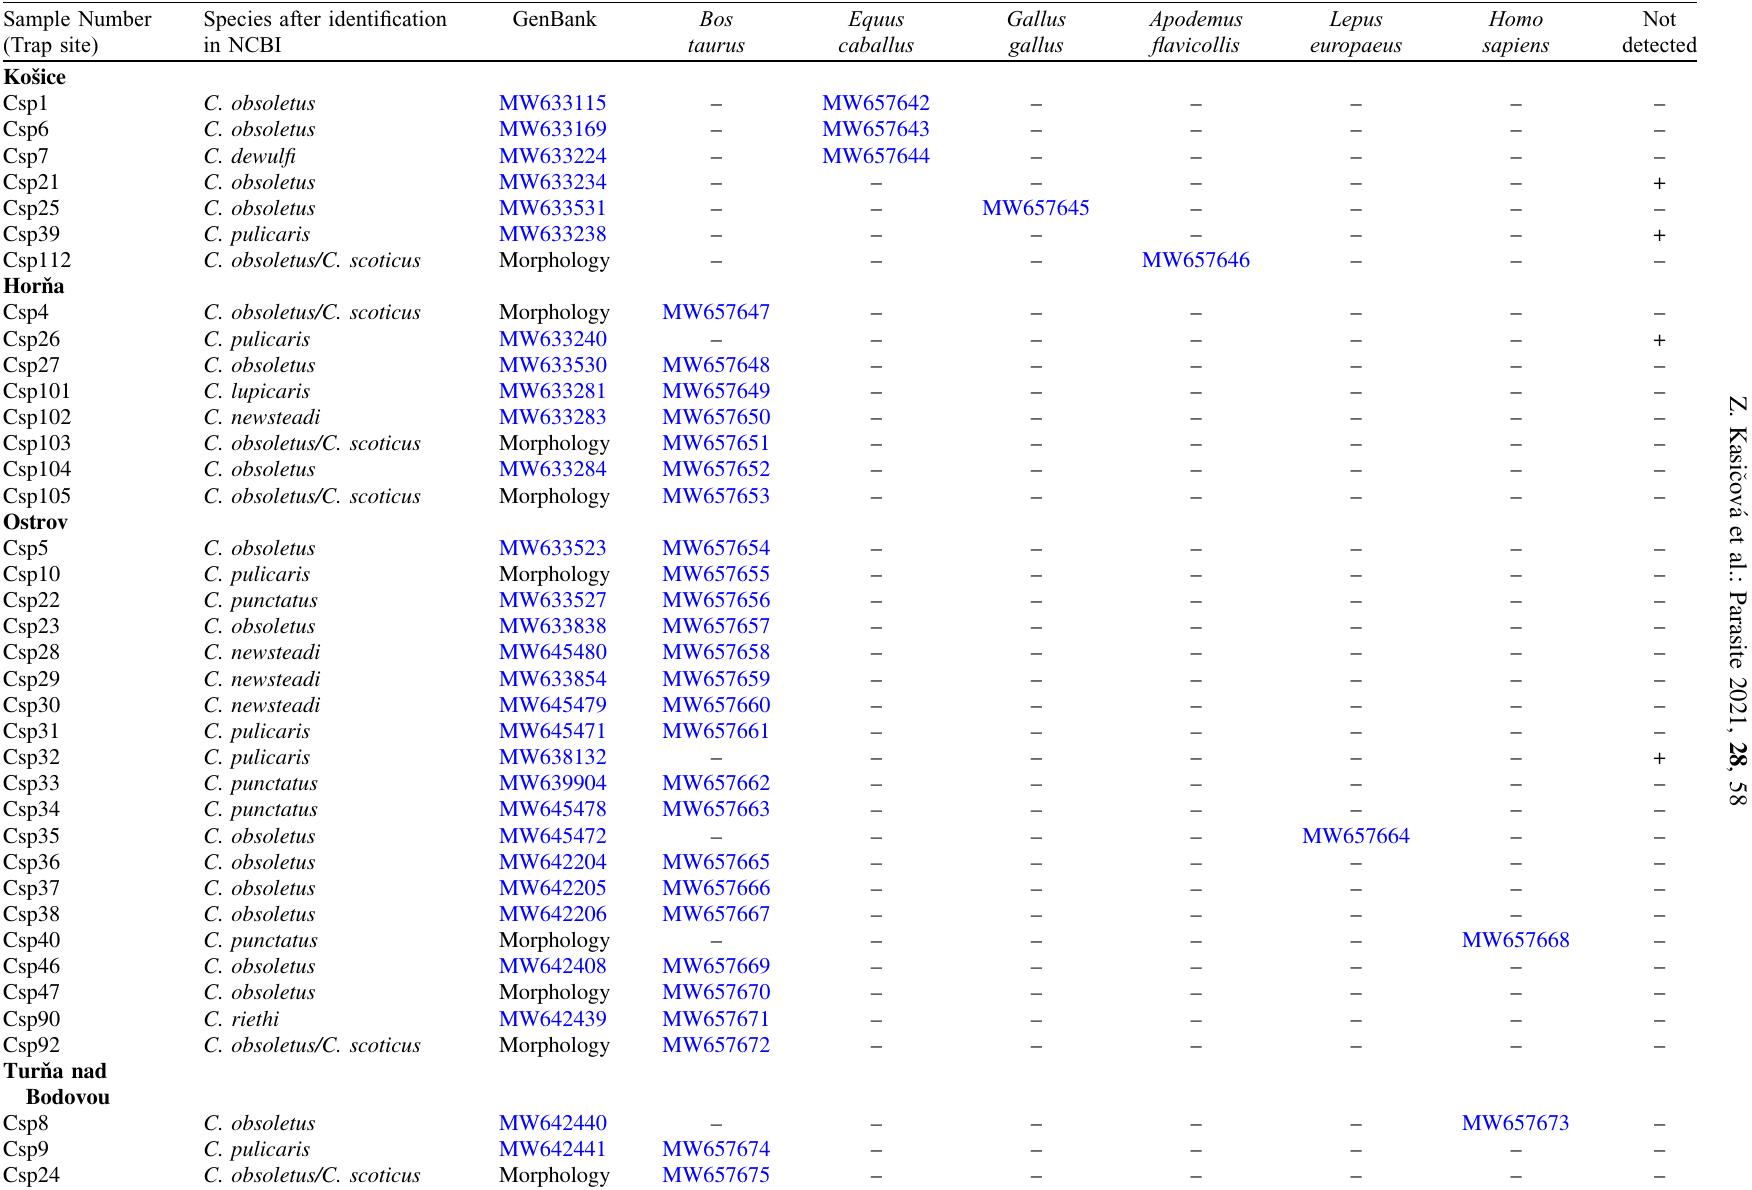
Table 1. Host blood meals from blood-fed Culicoides